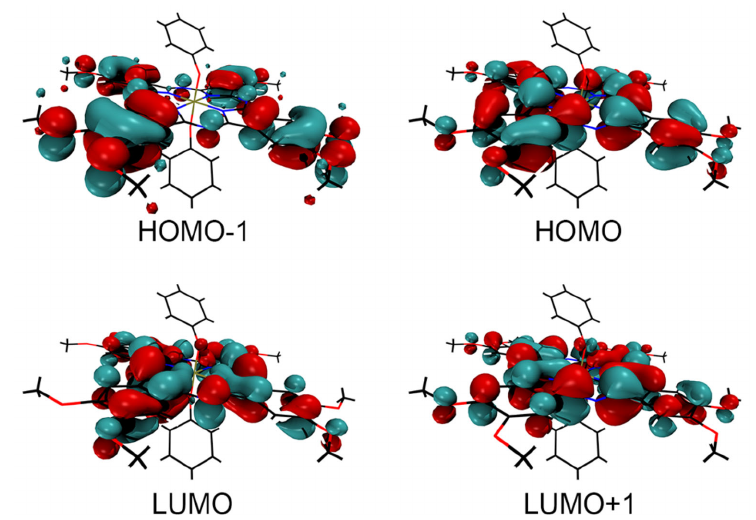
Figure 7. Boundary orbitals calculated for model complex ( β‐ OMe) 8 PcP(OPh) 2 . Note that neither of the axial phenyl rings holds any of the four boundary orbitals, hence no appreciable relaxation through charge transfer processes.